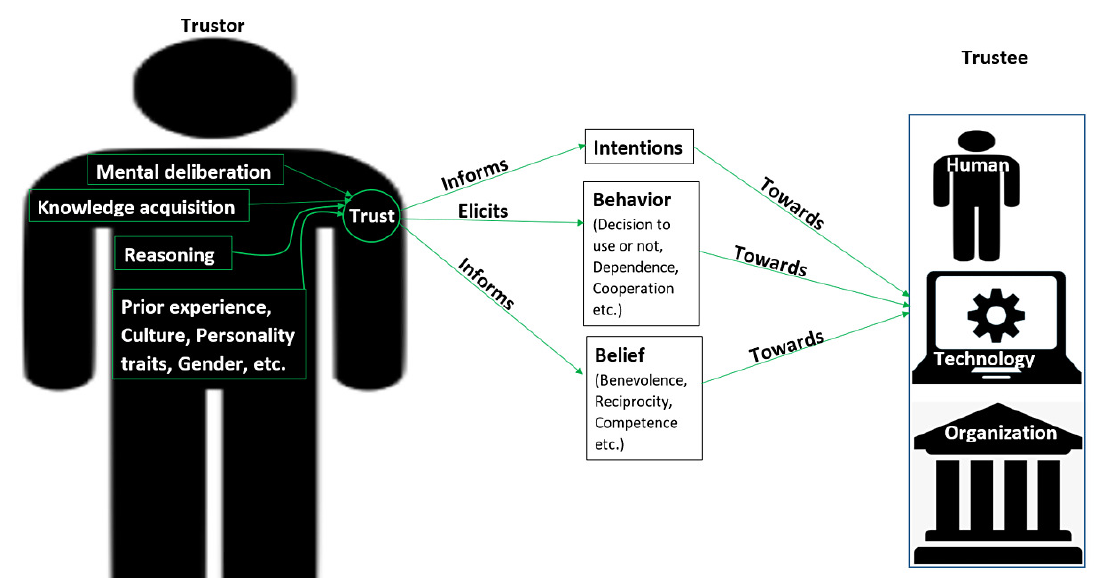
Figure 1. Conceptualization of the trust